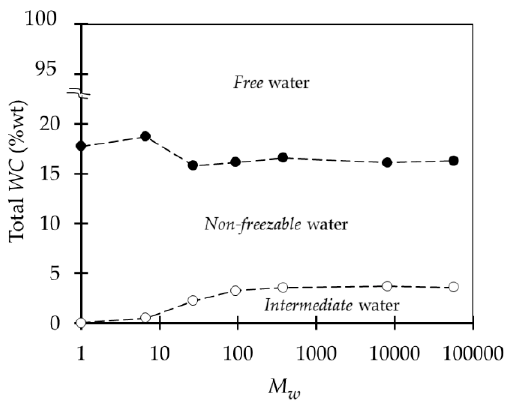
Figure 9. Water states distribution in PEG at different M w . (•) Non-freezable water; (o) intermediate water. Reprinted from [55] with permission of John Wiley & Sons.